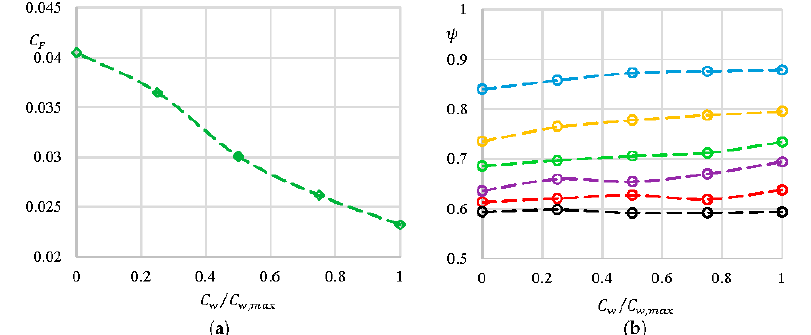
Dark: 𝜍 = 100% ,𝑅𝑒 = 1.11 × 10 (cid:2874) Figure 7. Axial thrust coe ffi cient from the measurements: ( a ) Increase of C F versus C w / C w , max for Figure 7. Axial thrust coefficient from the measurements: ( a ) Increase of 𝐶 (cid:3007) versus 𝐶 (cid:3050) 𝐶 (cid:3050),(cid:3040)(cid:3028)(cid:3051) ⁄ for ς = 20% and ( b ) Variations of ψ versus C ς ≥ 30%. 𝜍 = 20% and ( b ) Variations of 𝜓 versus 𝐶 (cid:3050) 𝐶 (cid:3050),(cid:3040)(cid:3028)(cid:3051) ⁄ for 𝜍 ≥ 30% . w / C w , max for